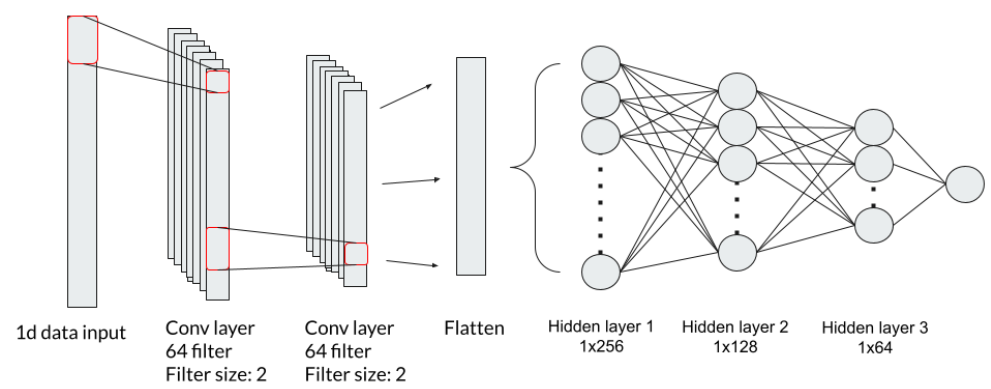
Figure 4. 1dCNN model structure (Visual representation of the model architecture with two one- dimensional CNN layers followed by three fully connected layers used in this